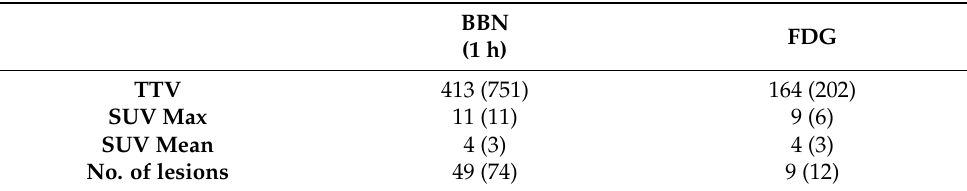
Table 6. Mean total tumor volume (TTV), SUV max, SUV mean and number of lesions by quantitative combined patient BBN vs. FDG